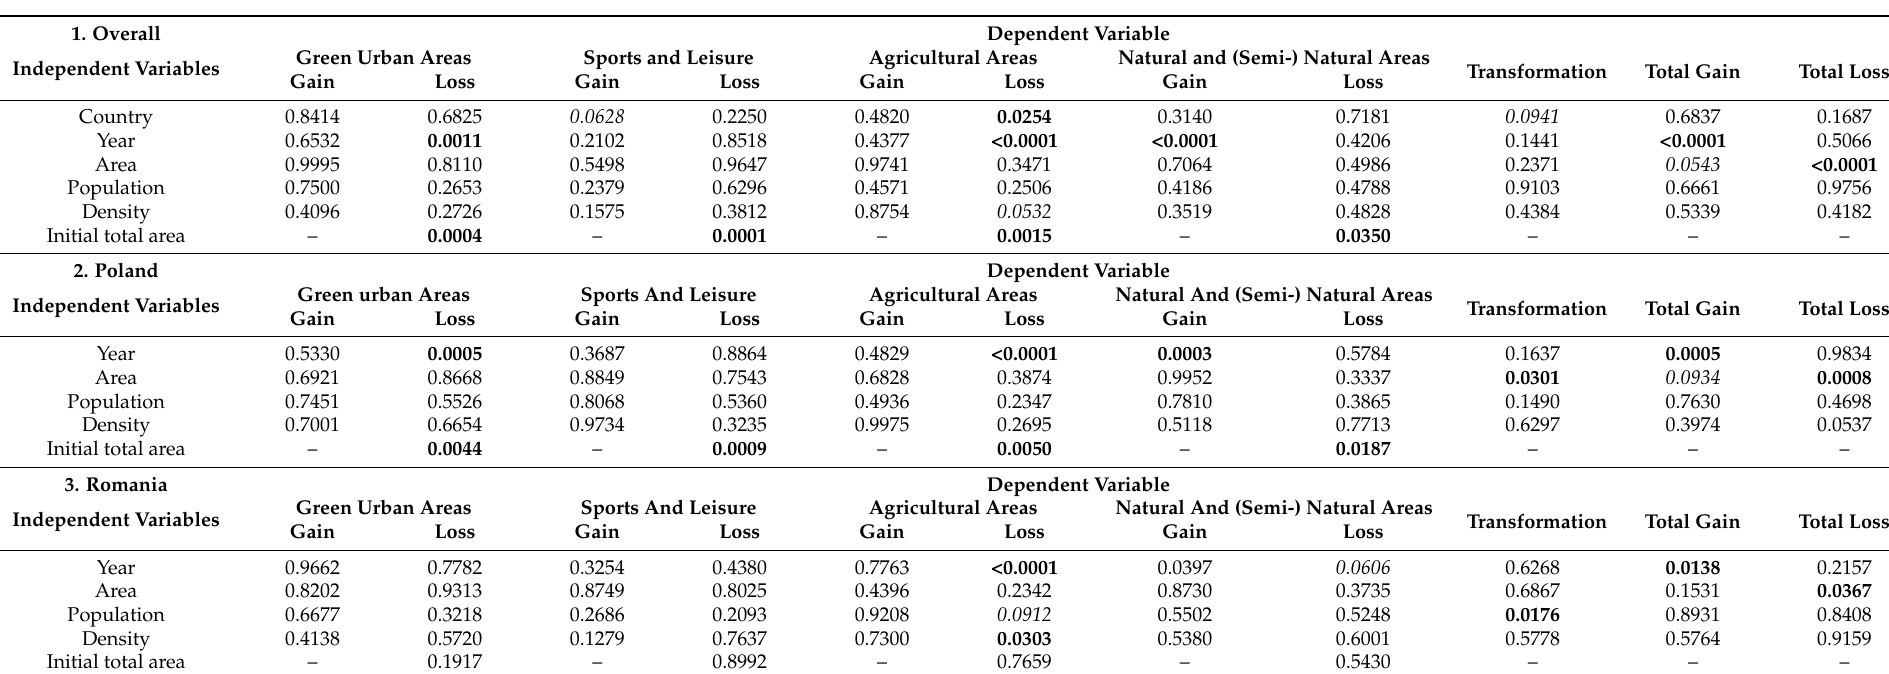
Table 3. Variables influencing the gain and loss of GI categories in Romanian and Polish cities covered by Urban Atlas data. The table displays the p value associated with each relationship, using the following notations: Bold —significant, p ≤ 0.05; Italic —significant, p ≤ 0.1; Regular—not significant, p >